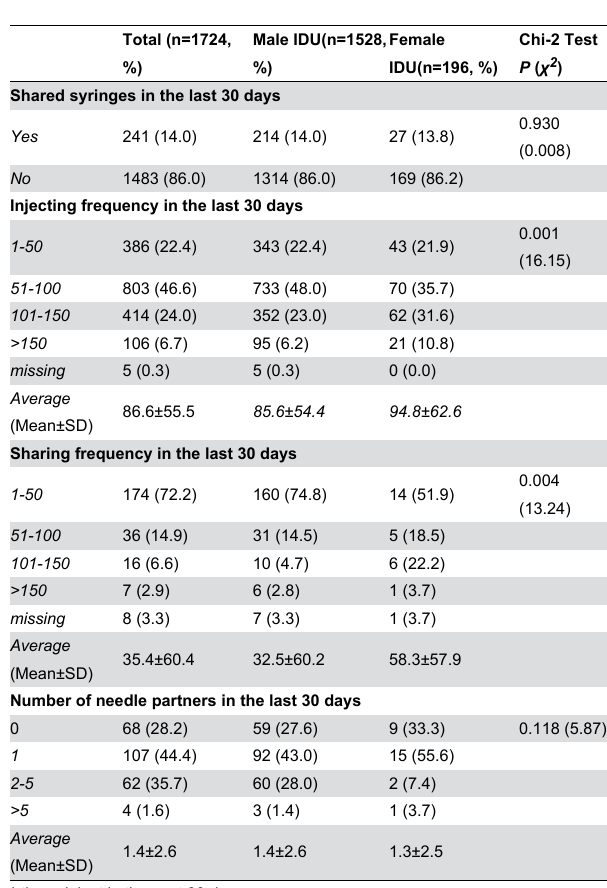
Table 2. Comparison of injecting drug-use behaviours among IDUs in the past 30